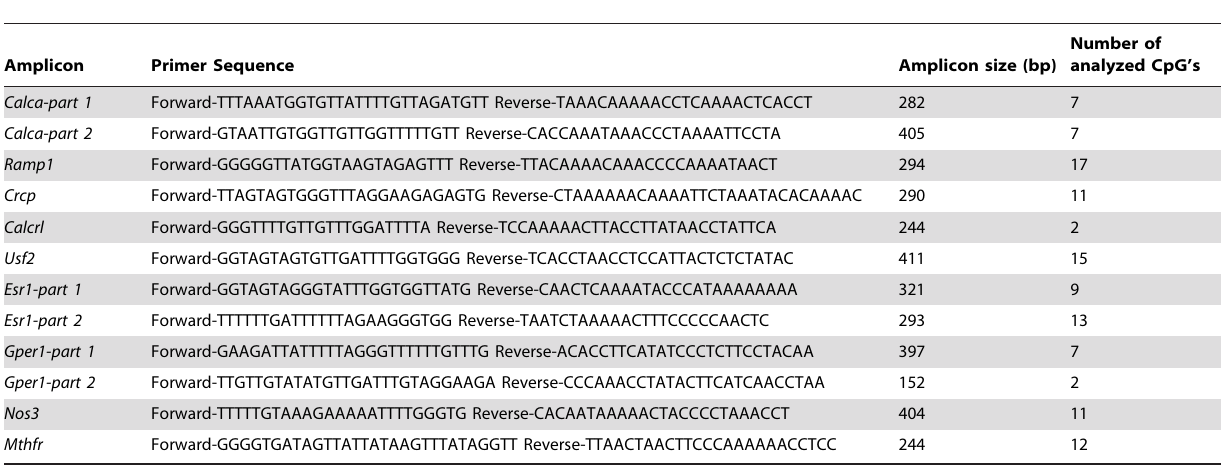
Table 1. Primers and conditions for PCR on CpG island located in the promoter region of genes of interest.